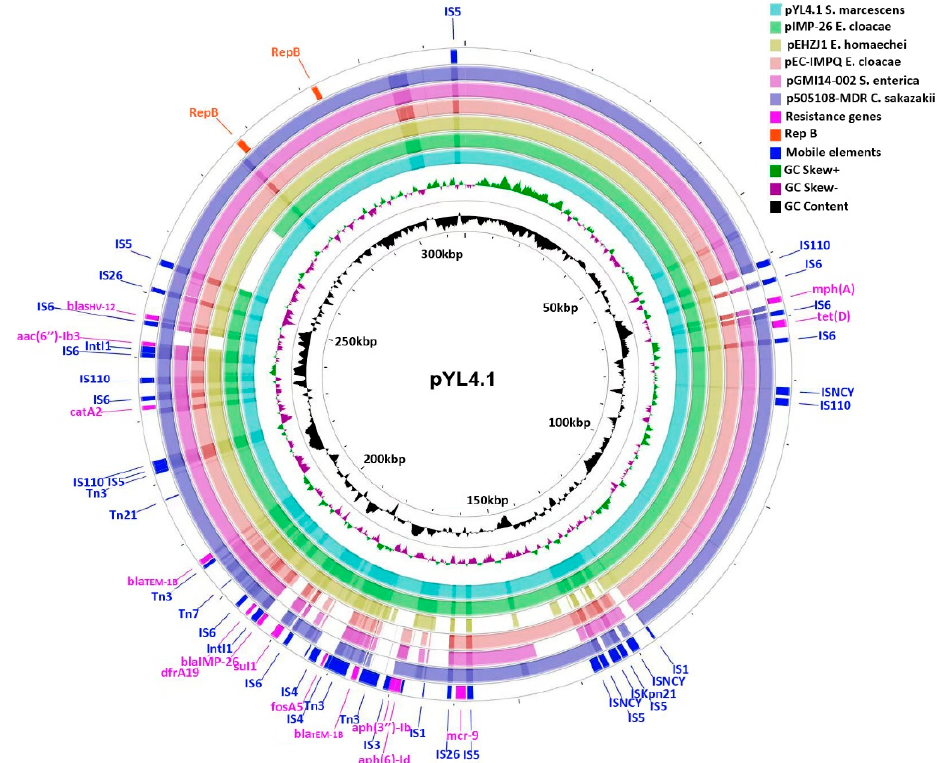
Figure 1. Genetic features of the pYL4.1 plasmid. Inner and outer circles correspond to average G+C content (black circle) and GC skew information (green and purple circles, respectively). The colored circles represent different plasmids (details are in the legend), and the Genbank numbers are as follows: pIMP26 (MH399264), pEHZJ1 (CP033103), pEC-IMPQ (EU855788), pGMI14-002 (CP028197), p505108-MDR (KY978628). An outer cyan-blue circle shows where resistance genes and IntI are located. The location of the resistance genes (magenta), insert elements (blue), and replication origins (orange) are also shown outside the round and tagged by different colors.